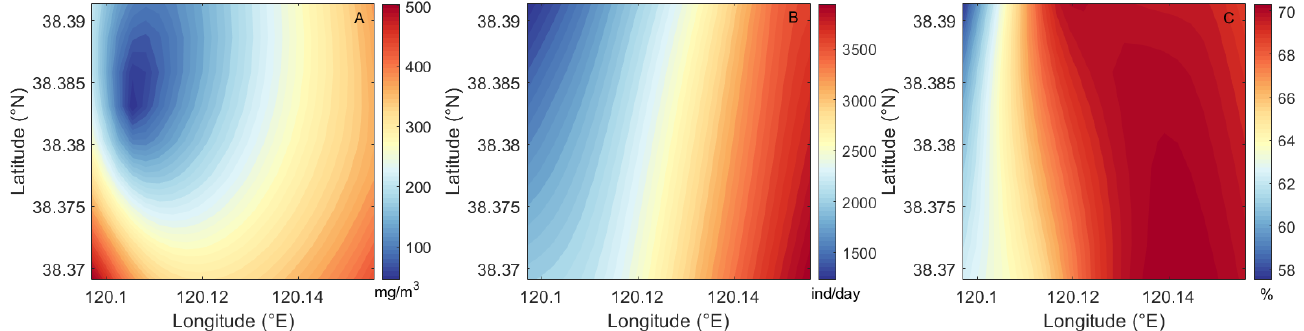
Figure 7. Distribution of the interpolated TPH concentration ( A ), death rate ( B ) and mortality ( C ) of Chaetoceros on 18 June.